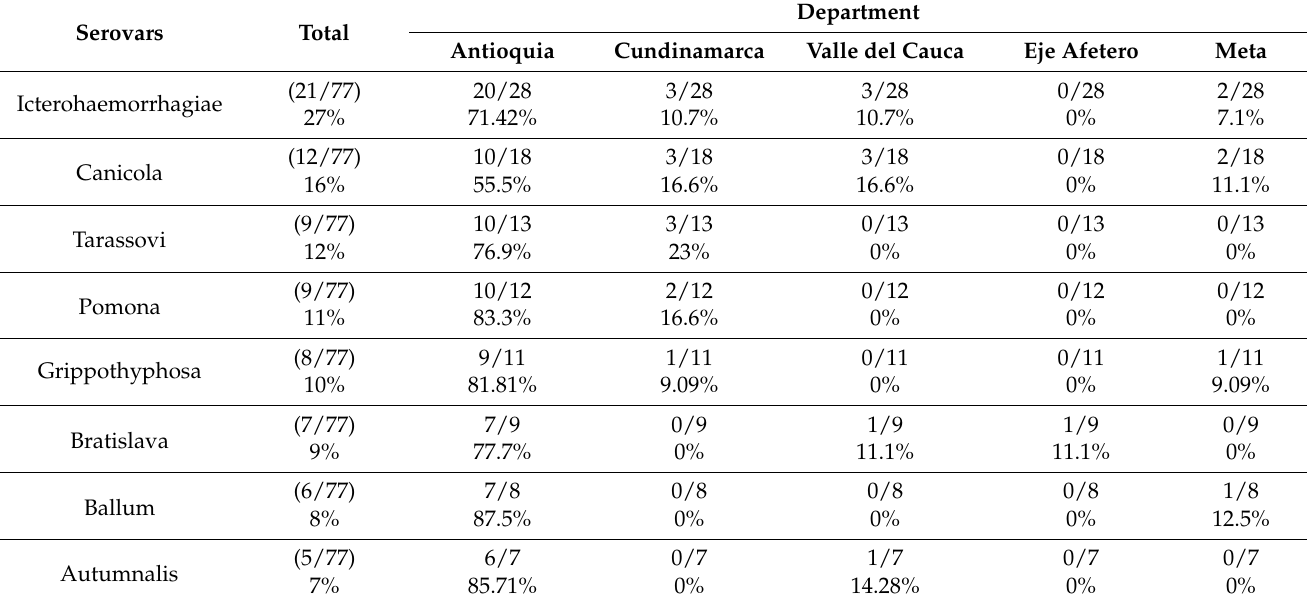
Table 3. The distribution of different Leptospira serovars found in each department included within the